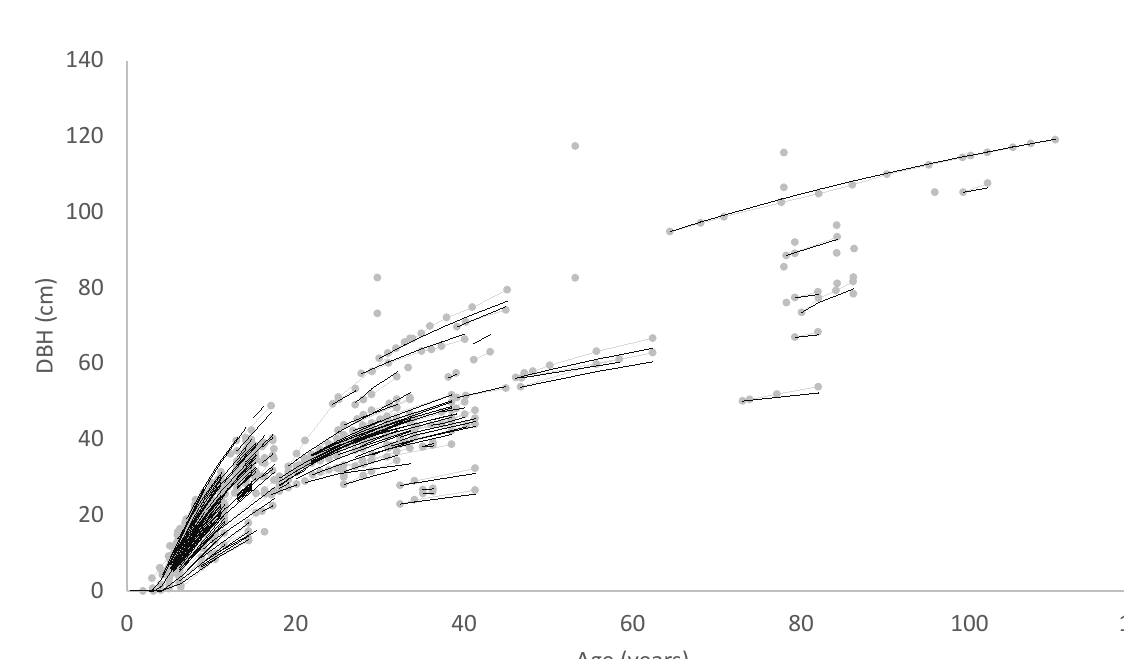
Figure 5. Quadratic mean DBH vs. age for the plot measurement database. Grey dots indicate measurements, with grey solid lines showing plots measured multiple times. Black lines show predictions from Equation (18) based on the initial measurement in each plot.